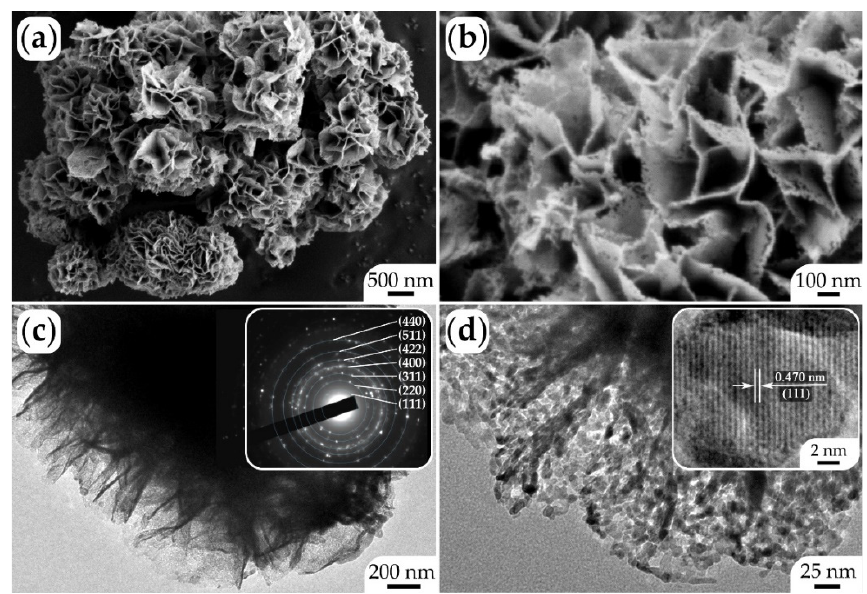
Figure 5. Microstructure ( a , b —SEM; c , d —TEM) of the obtained hierarchically organized NiCo 2 O 4 nanopowder; SAED ( c , inset) and HR-TEM results ( d , inset).